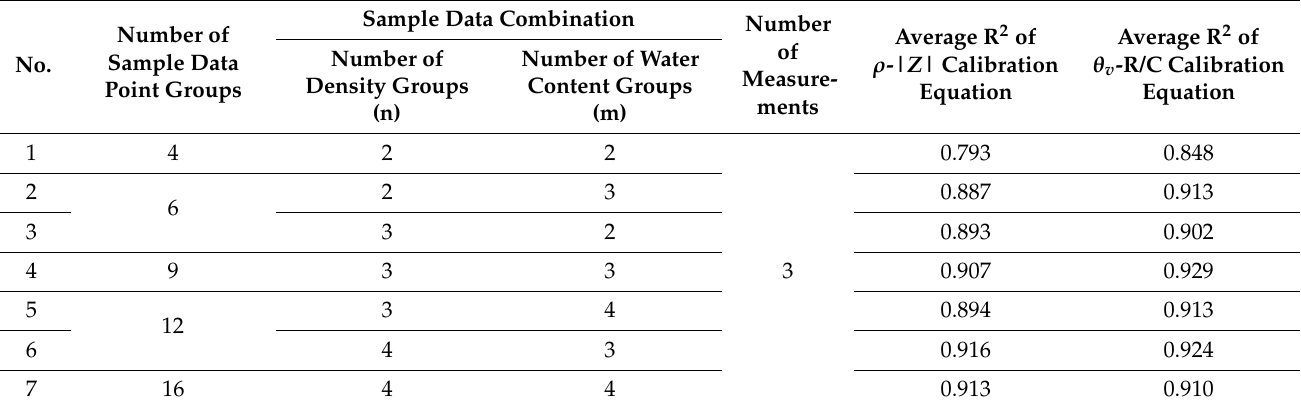
Table 6. Correlation coefficients of soil calibration models for different sample